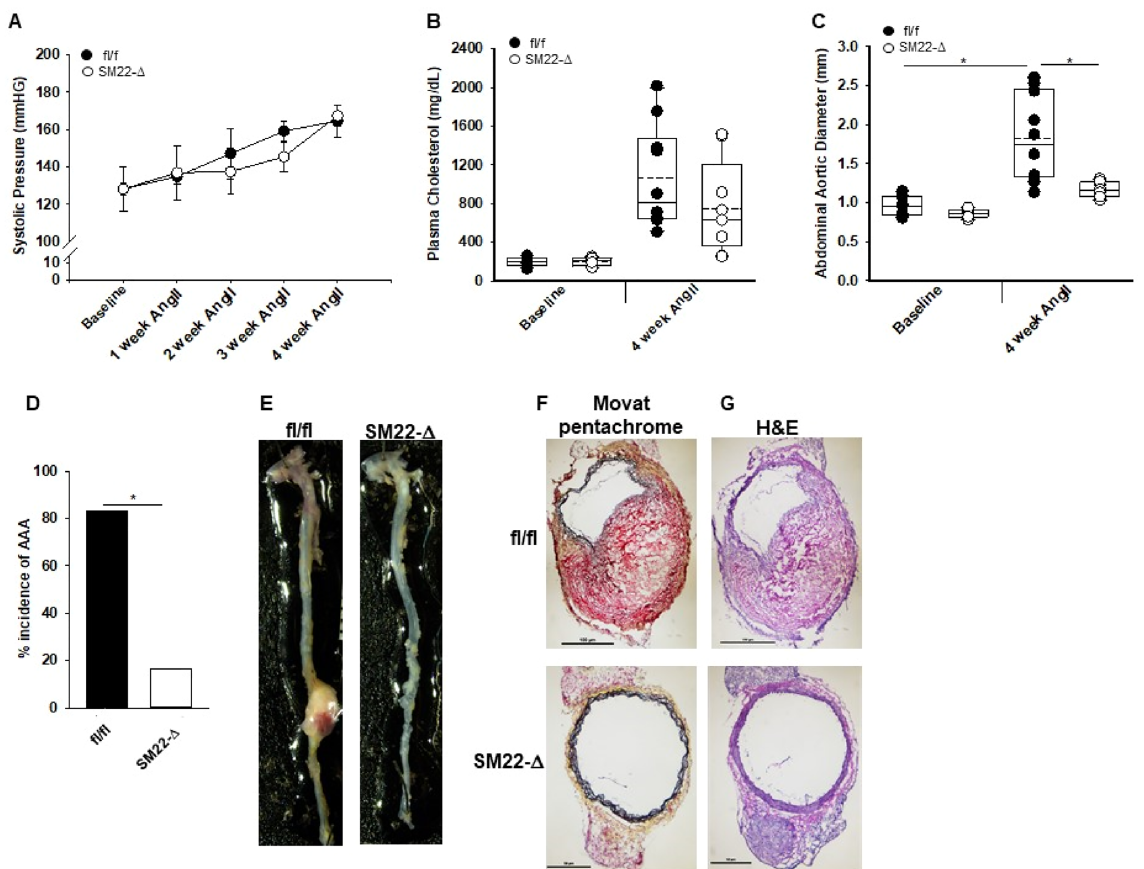
Figure 3. Loss of smooth muscle cell Plpp3 reduces abdominal aortic aneurysm development. ( A ) Systolic blood pressure measurements from fl/fl (n = 4) and Sm22-Δ (n = 3) mice treated with AngII for 4 weeks. ( B ) Plasma cholesterol at baseline and post-4 week AngII were measured in fl/fl (n = 10) and SM22-Δ (n = 7) mice. ( C ) Abdominal aortic diameter measurements of fl/fl (n = 10) and SM22-Δ (n = 8) were measured using ultrasound at baseline and 4 week AngII. * P < 0.001, Two-way ANOVA, Holm-Sidak, all pairwise multiple comparison. ( D ) Percent incidence of AAA in fl/fl (n = 10) and SM22-Δ (n = 7) mice treated with AngII for 4 weeks. ( E ) Representative images of aortas from fl/fl and SM22-Δ. ( F ) Representative movat pentachrome stained images of abdominal aorta from fl/fl and SM22-Δ mice following 4 week AngII treatment. ( G ) Representative H&E stained images of abdominal aorta from fl/fl and SM22-Δ mice following 4 week AngII SM22-Δ mice as measured by ultrasound (Supplemental Figure V). At one week after AngII infusion, plasma cholesterol (738 ± 176 vs 749 ± 257 mg/dL; P = 0.946) and triglycerides (323 ± 115 vs 356 ± 207 mg/dL; P = 0.779) were not significantly different between fl/fl vs SM22-Δ animals. Movat pentachrome and H&E staining revealed an overall similar aortic structure between genotypes with no difference in elastic breaks (Supplemental Fig- ure V), adventitial thickening (0.33 ± 0.19 vs 0.17 ± 0.02 µm 2 ; P = 0.276), medial thickening (0.346 ± 0.1.16 vs 0.188 ± 0.101 µm; P = 0.101), TUNEL staining (Supplemental Figure V), CD68 staining (Supplemental Figure VI), collagen hydrolyzing peptide (Supplemental Figure VII), or picrosirius red staining (Supplemental Figure VIII) in fl/fl and SM22-Δ mice at this early time point. Despite these histologic similarities, gene array expression data demonstrated lower levels of Ctgf , Icam1 , and Ccl2 in SM22-Δ tissue (Fig. 5A), consistent with alterations in inflammation and extracellular matrix pathways following AngII treatment. Additionally, Acta2 expression was significantly decreased with no change in Mmp9 in SM22-Δ abdominal aortas one week after AngII treat- ment (Fig. 5B). To understand whether these differences reflected alterations in the phenotypic state of SMCs, aortic SMCs were isolated from fl/fl and SM22-Δ mice and treated with AngII in culture. As expected, Plpp3 expression was significantly lower in SM22-Δ than fl/fl cells (Fig. 5C) following AngII treatment. SMCs from SM22-Δ mice had significantly reduced levels of Myh11 and Col1a1 with a trend of decreasing Acta2 gene expression (Fig. 5C). While vimentin gene expression was not increased in isolated SMCs from SM22-Δ mice following AngII treat- ment, vimentin staining (Fig. 5D) was increased within the medial layer of aortas from SM22-Δ mice following 1 week AngII infusion, suggesting a fibroblast-like phenotype. In keeping with these observations, FSP-1 (Fig. 5E) staining was higher within the medial layer of aortas from SM22-Δ mice. Recently, the pluripotency factor Oct4 has been demonstrated to regulate SMC function and phenotypic switching 29 . We observed significant